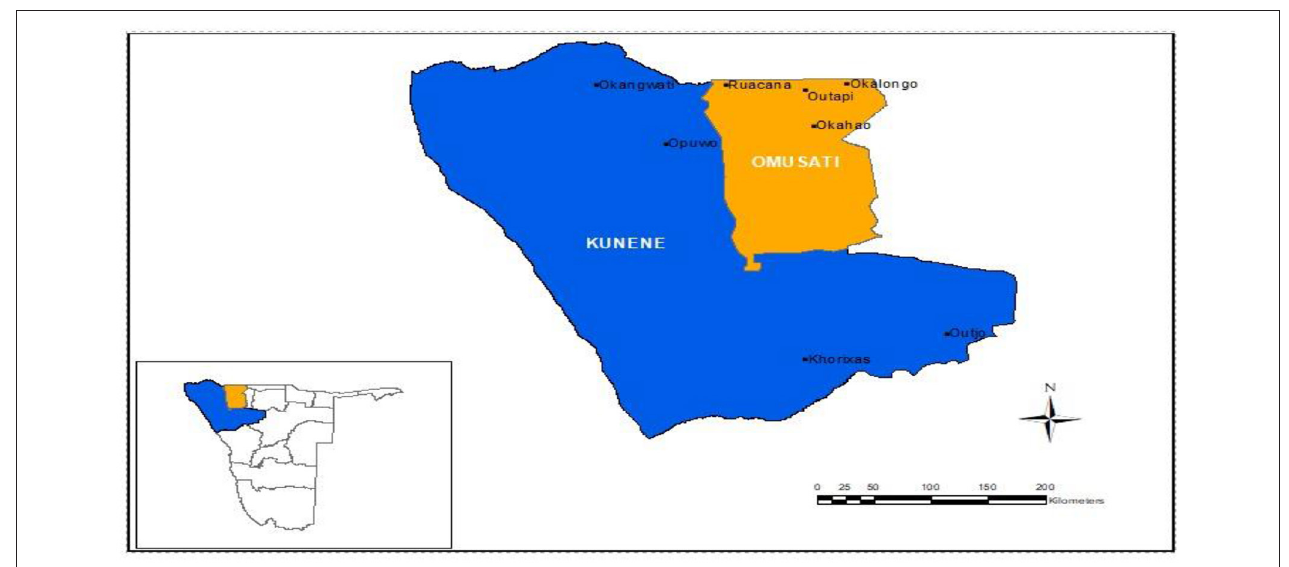
FIGURE 1 | Map of the study